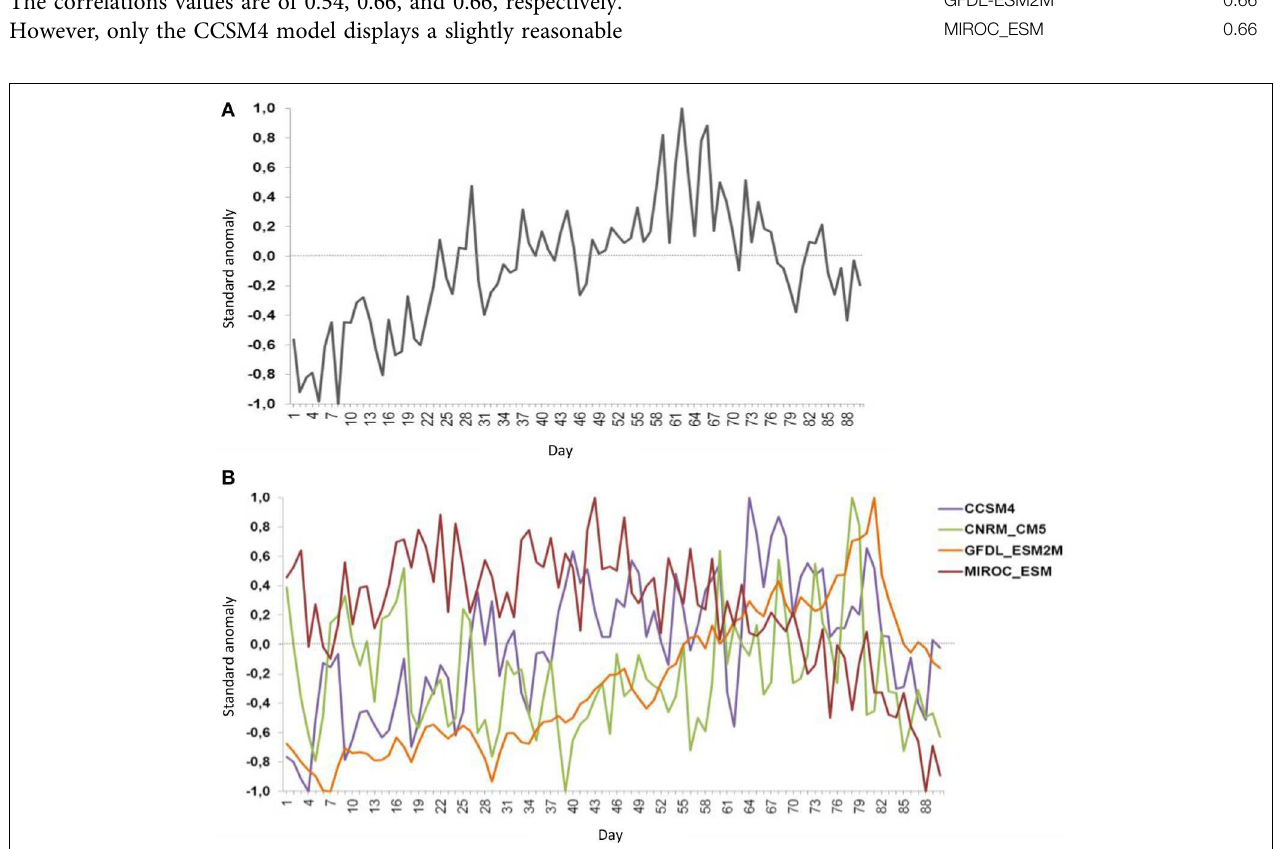
FIGURE 4 | Observed (A) and simulated from the CMIP5 models (B) daily precipitation over the north of the NEB during FMA season from the 1963–2003 period.